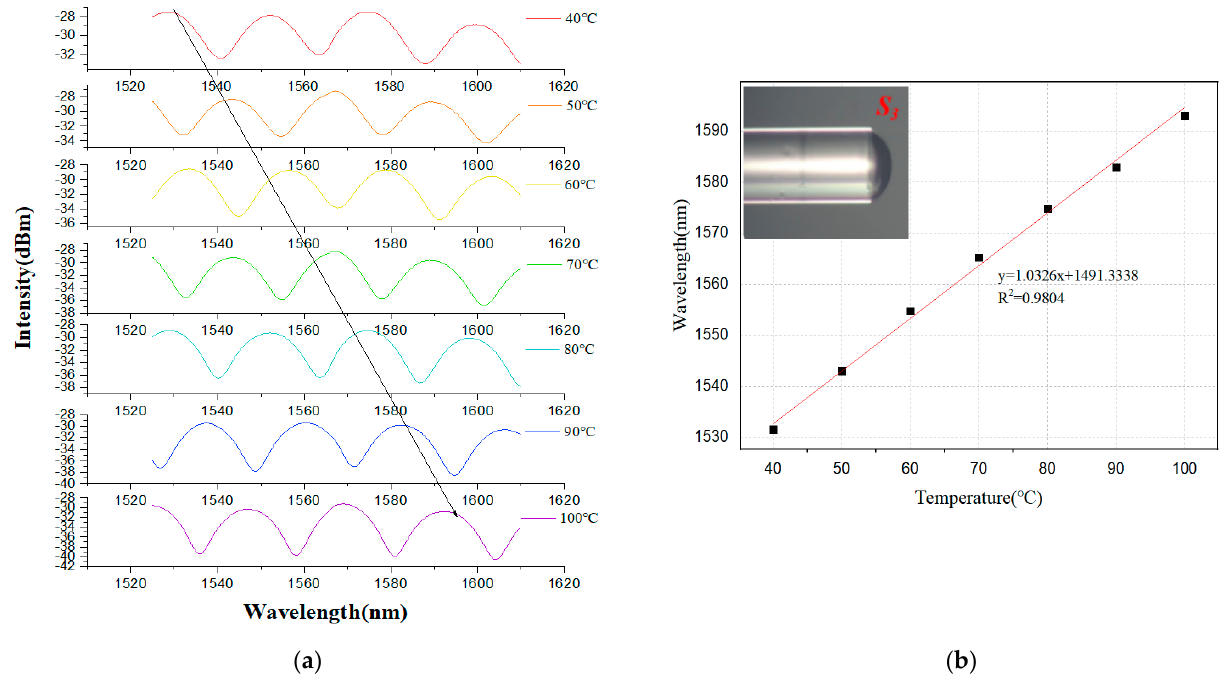
Figure 8. ( a ) The temperature (ranging from 40 to 100 °C, in strides of 10 °C) response interference Scheme 3. (PDMS/Ecoflex0030); and ( b ) temperature sensitivity of S 3 .